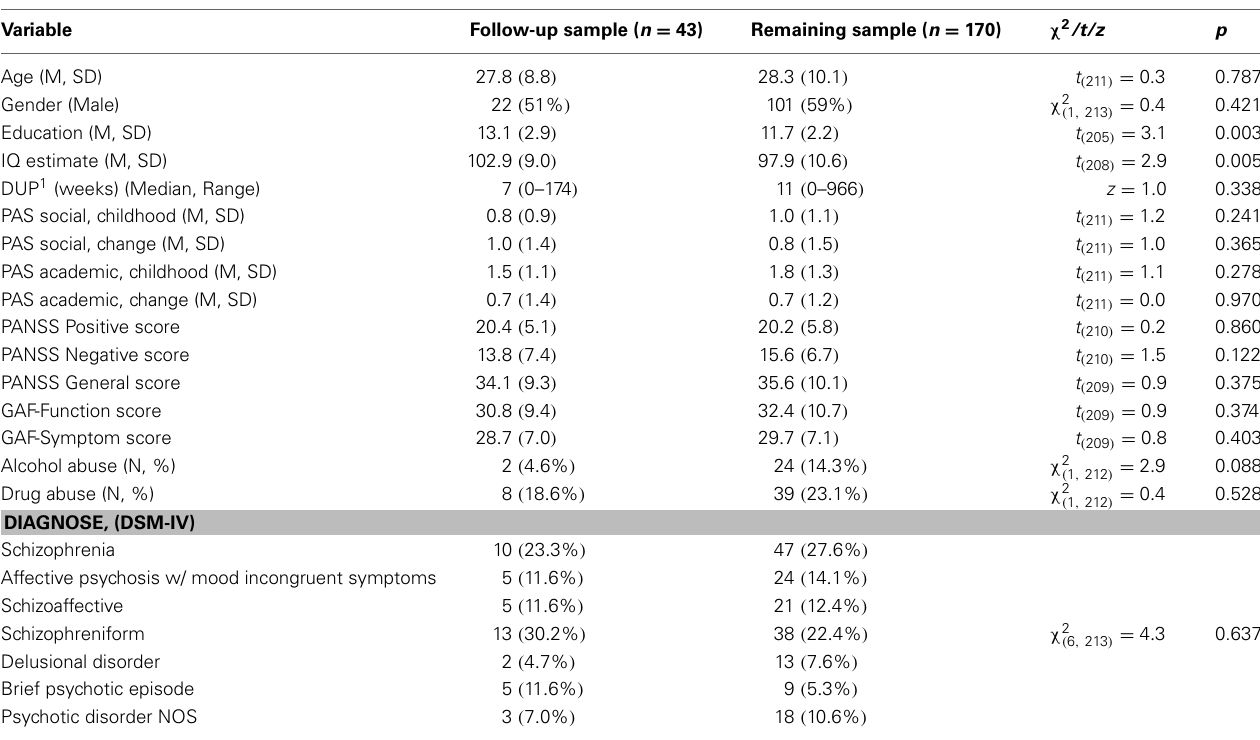
Table 2 | Demographic variables and symptom scores at